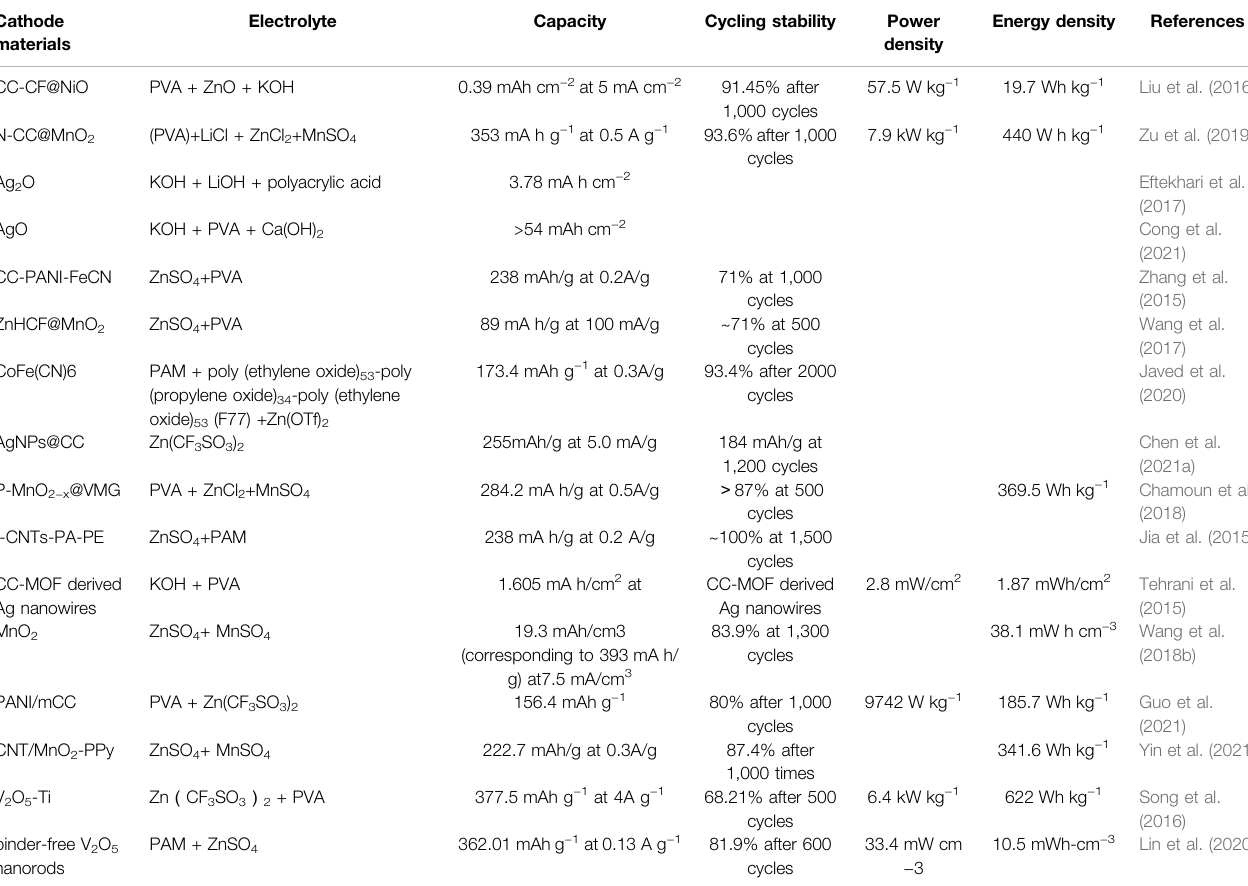
TABLE 1 | Comparison of electrochemical properties of different cathode materials. Cathode materials